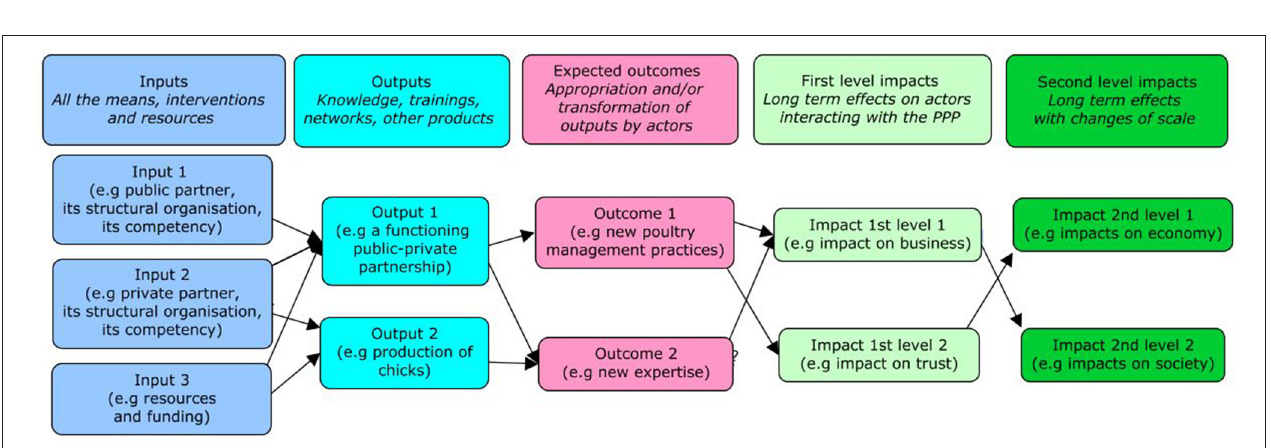
FIGURE 1 | Simplified graphic of an impact pathway. Some hypothesis were made on the potential inputs, outputs, outcomes, and impacts of the PPP evaluated to illustrate the impact pathway.